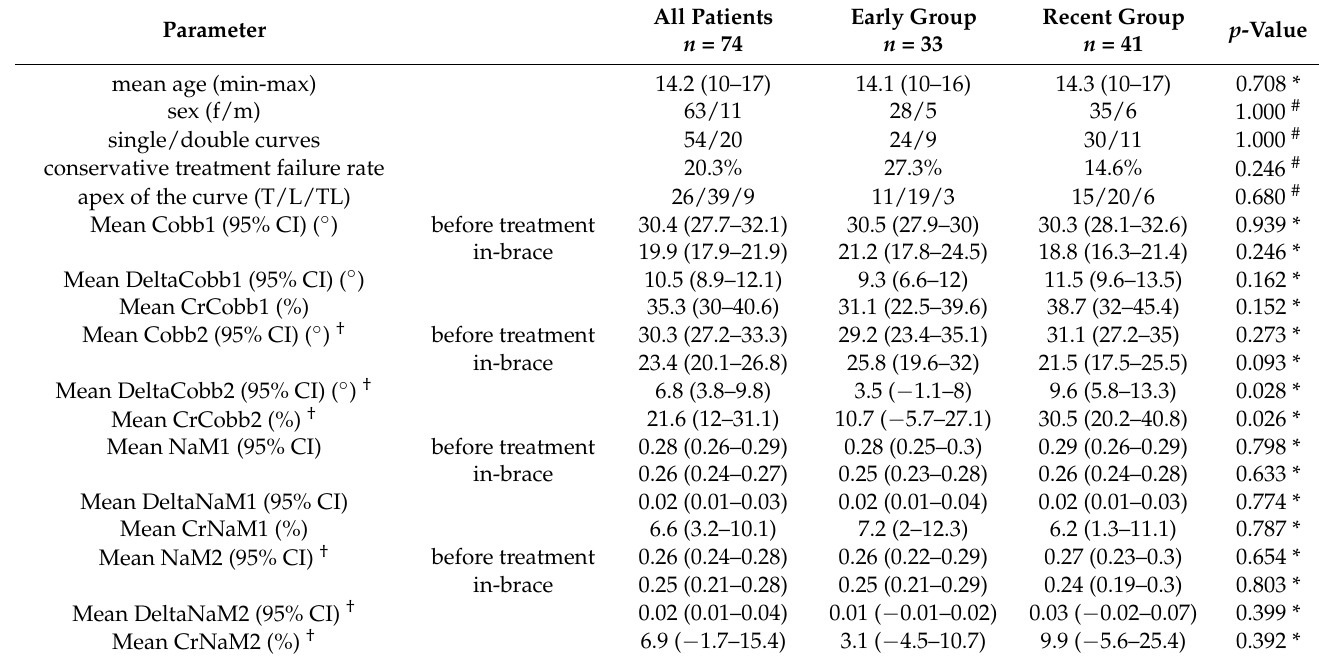
Table 1. Patient characteristics and radiographic measurements.